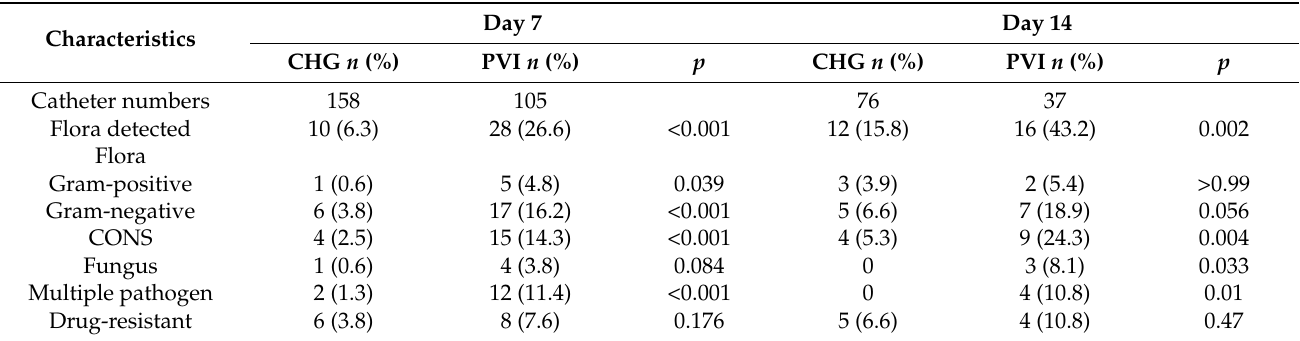
Table 3. Incidences and microbiologic features of microbial colonization at the central catheter insertion sites.